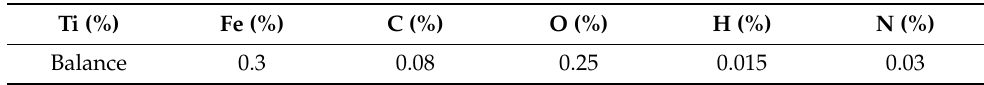
Table 1. Chemical composition of cp-Ti used as substrate—at%.